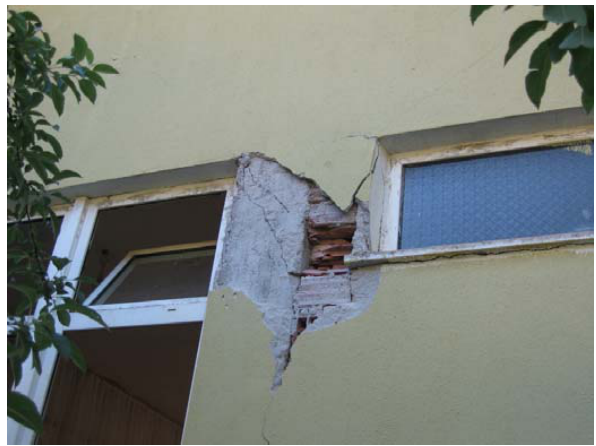
Fig. 11. Shear-column damage.